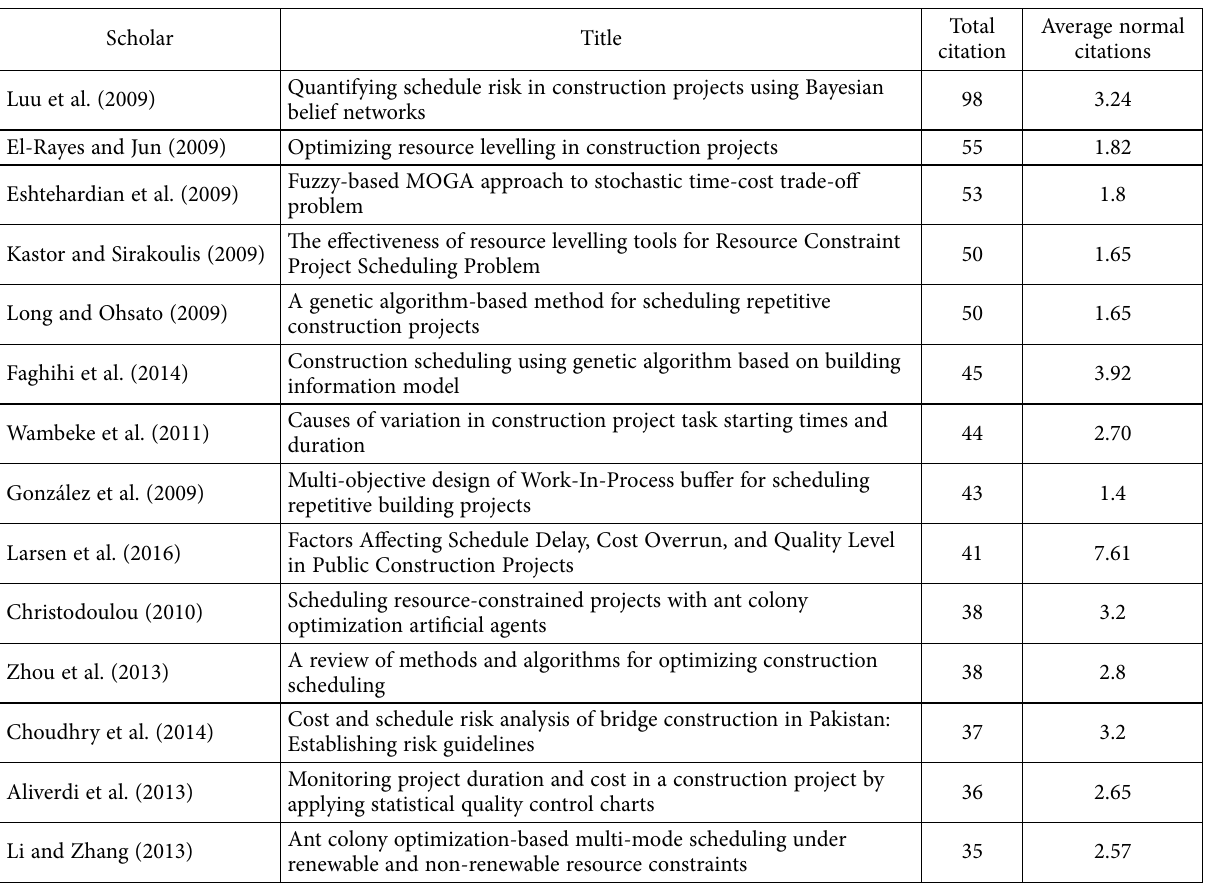
Table 5. List of publications with the highest impact in